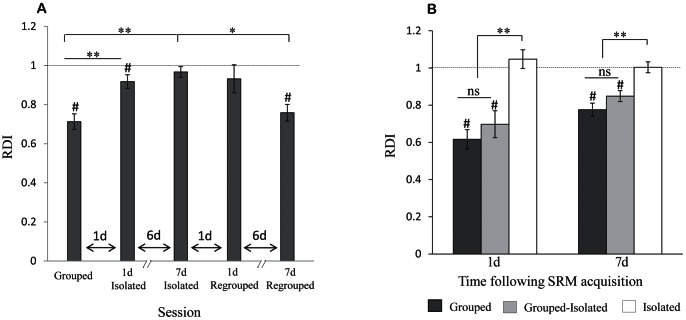
Social isolation rapidly induced a reversible impairment in consolidation of long-term SRM (mean±SEM).A) RDI values of two 5 min encounters, 120 min apart, with the same juvenile. This test was repeated with the same group of adult animals (n = 13) while their housing conditions were changed, using new stimuli for every session. Long-term SRM was confirmed for every session if a paired t-test found a significant reduction in SIT between the first and second (#
p<0.05). After isolation for 1 day (1 d isolated) the rats showed a significant increase in their RDI values from when they were housed in groups (Grouped) and following 7 days of isolation (7 d isolated) the rats were unable to acquire long-term SRM. This effect was reversed following 7 days (7 d Regrouped), but not 1 day (1 d Regrouped) of return to group housing. Repeated ANOVA, F(4,48) = 6.96, p<0.001, Bonferroni post hoc: *p<0.05, **p<0.01. B) RDI values of 5 min encounters with the familiar and a novel juvenile 30 min apart, 1 d (left) and 7 d (right) after three consecutive 5 min encounters with the familiar juvenile (retroactive facilitation, Fig. 1B). Male rats from group housing, isolated immediately after the retroactive facilitation (Grouped-Isolated, light gray bars), displayed SRM both 1 day and 7 days later, as did males kept in group housing throughout the experiment (Grouped, dark gray bars). In contrast, rats kept in solitary cages for 7 days before SRM acquisition and throughout the experiment (Isolated, empty bars) did not retain the memory even for 1 day. Long-term SRM was assessed by paired t-test (# p<0.05) on SIT values between the encounters with the familiar and the novel juvenile. For both 1 day and 7 days intervals no statistically significant difference in RDI was found between Grouped and Grouped-Isolated animals, whereas Isolated rats differed from the other two groups (1-way ANOVA, 1 d: F(2,21) = 14.9 p = 0.001; 7 d: F(2,21) = 13.7, p<0.001, Bonferroni post hoc: **p<0.01, n = 8 per group.